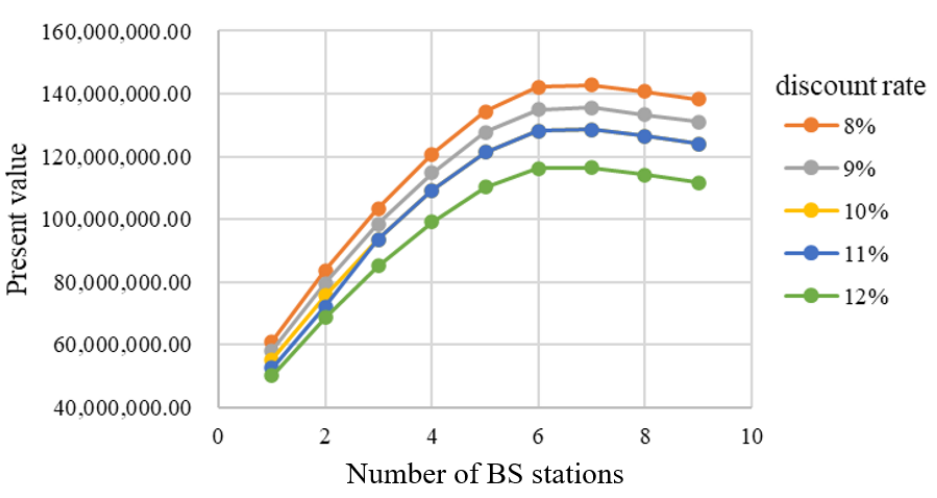
Figure 17. The present value of each